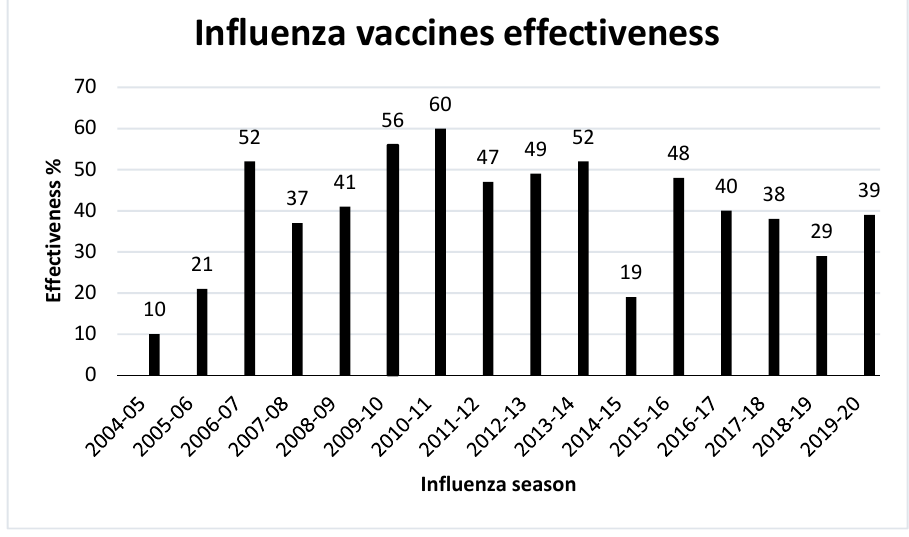
Figure 6. Fluctuation of seasonal influenza vaccines effectiveness from 2004–2020 in US, according to CDC